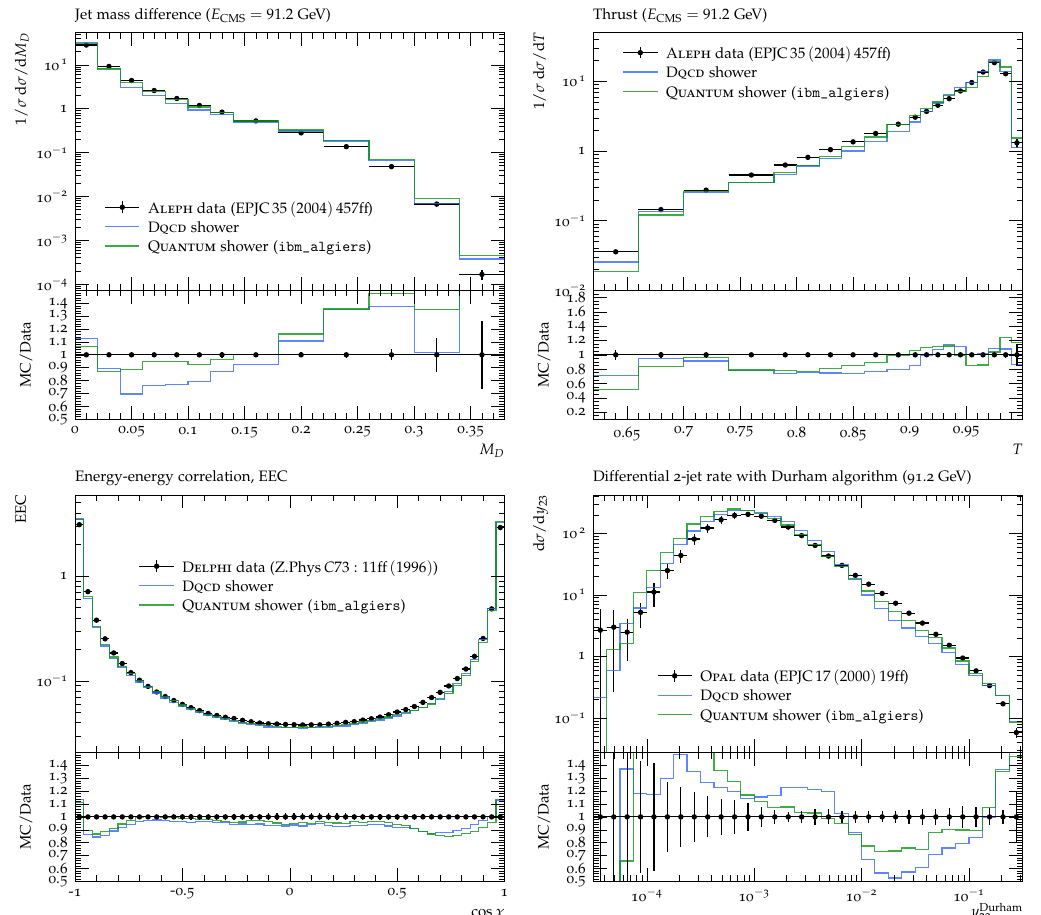
Figure 6. Sample comparisons of the Discrete QCD model and the Quantum Parton Shower to data taken at the LEP collider [69–71]. The Quantum Parton Shower results are not corrected for errors in the qubit